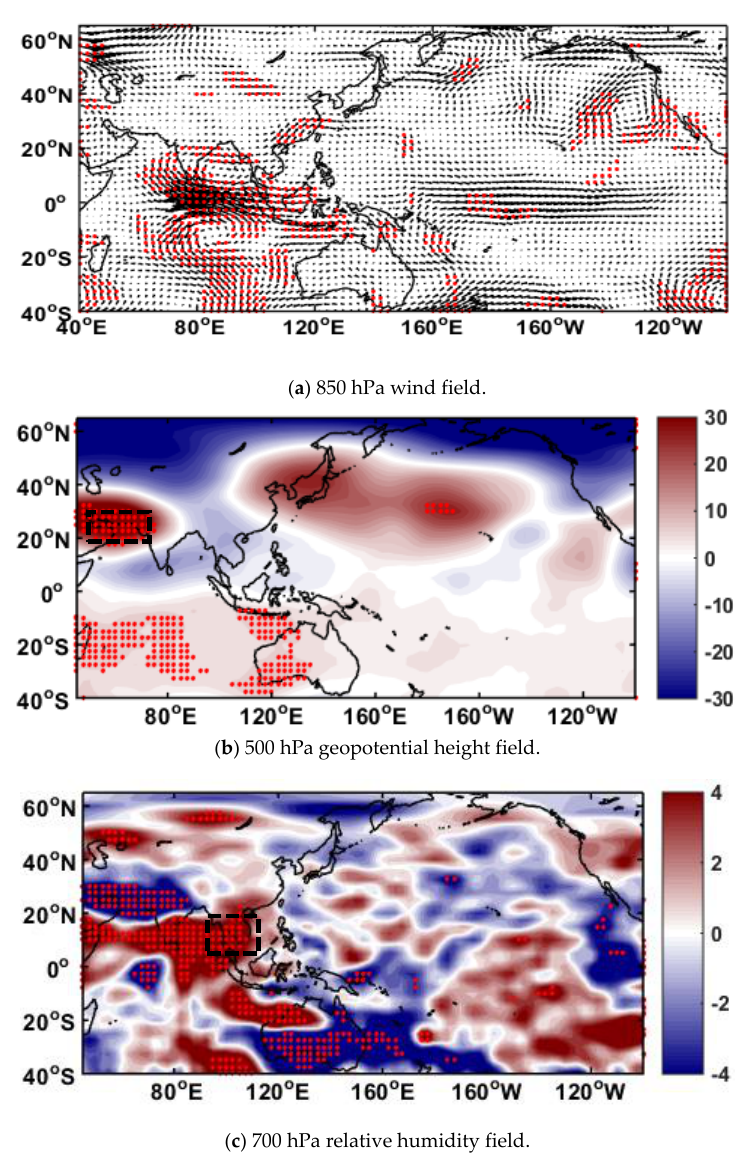
Figure 5. Regression maps based on TIOD (the marked areas indicate statistically significant values at the 5% level).